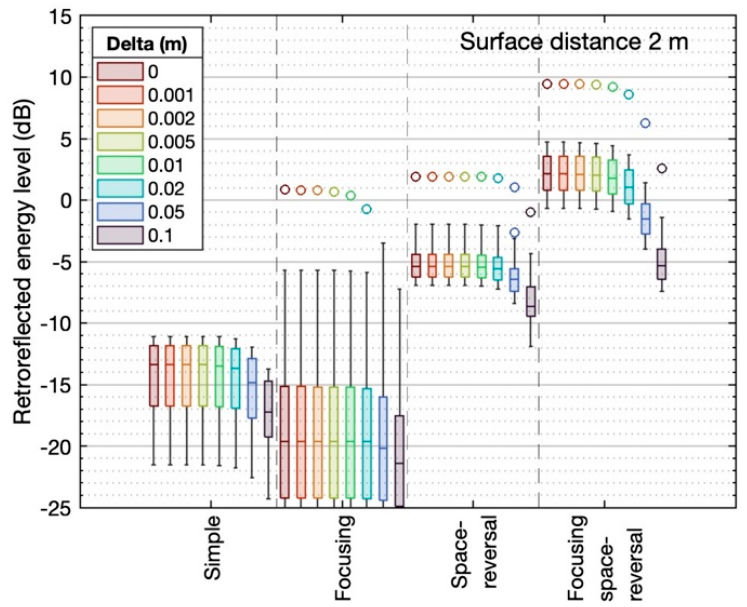
Figure A3. Distribution of retroreflected energy levels for 25 collocated source-receivers for various random elementwise delay ranges, represented by delta ( 𝛿 ). The reflector is a 2.4 × 2.4 m square, and the 25 source-receivers are in a 2.4 × 2.4 m square offset from the reflector at 2 m with a patch size of 1.2 m. Values are speech-A-weighted.